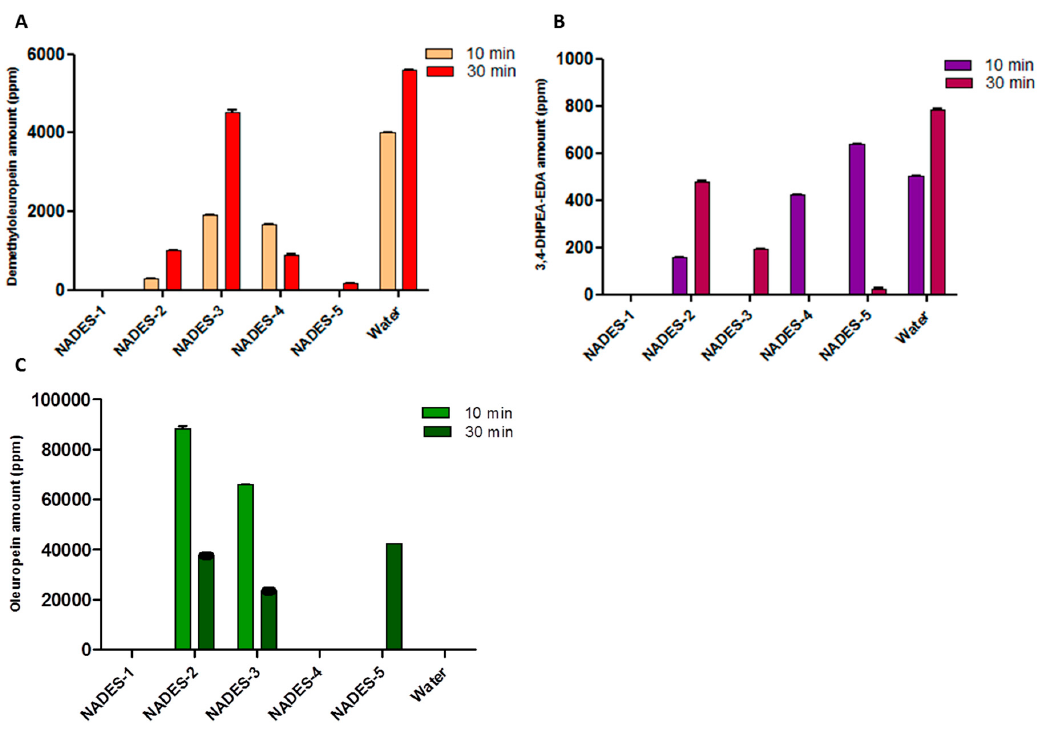
Figure 3. Quantitative analysis, carried out by HPLC, of demethyloleuropein ( A ), 3,4-DHPEA-EDA ( B ) and oleuropein ( C ) in ripe olives extracted with NADESs and water (for control). The extractions were carried out for a duration of 10 and of 30 min.